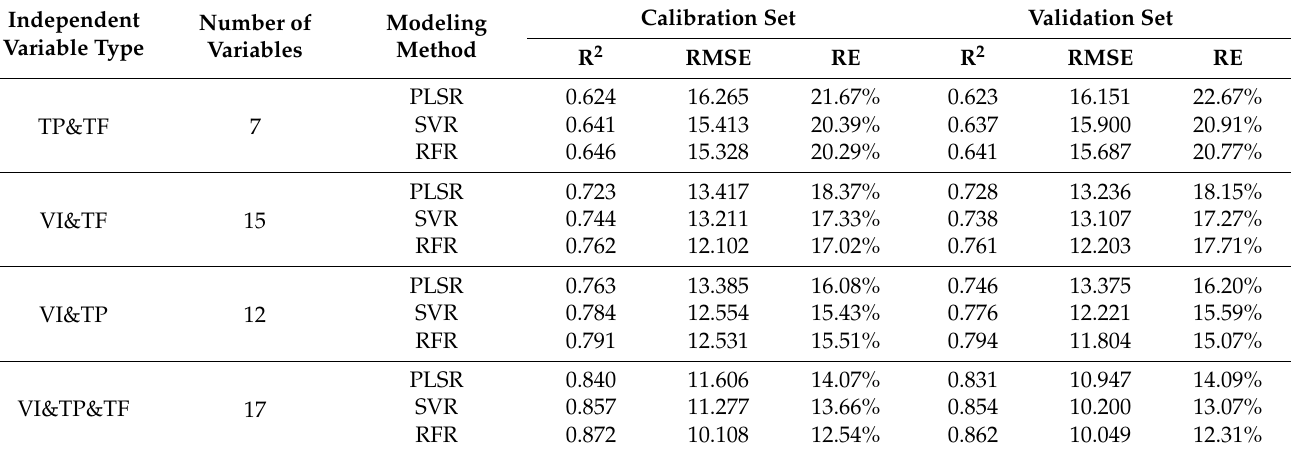
Table 4. Estimation performance of multi-source collaboration models based on different algorithms.